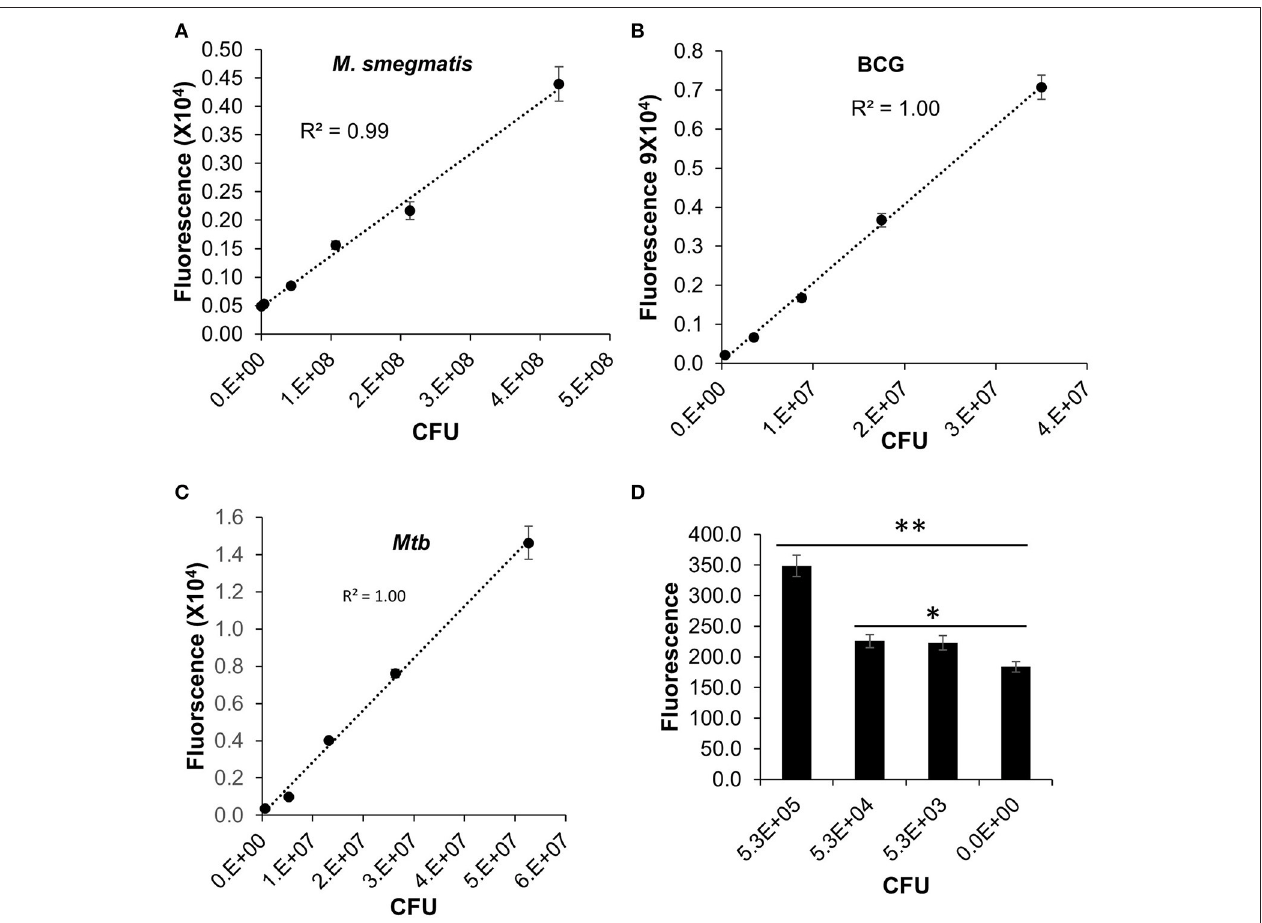
FIGURE 4 | Direct labeling of different mycobacteria with DLF-1. Fluorescent intensities of DLF-1 labeled bacteria were plotted against the numbers of bacteria. (A – C) represent plots for M. Smegmatis, M. bovis BCG , and Mtb CDC1551, respectively. Linear trend lines with R-squares are also displayed for each plot. Linear range: M . smegmatis 4.3 × 10 5 − 4.3 × 10 7 ; M. bovi s BCG 3.5 × 10 4 − 3.5 × 10 7 ; and Mtb 5.3 × 10 4 − 5.3 × 10 7 . (D) Minimum number of Mtb within the detectable linear range. ** P < 0.01; * P < 0.05. Error bars represent standard errors of means calculated based on results from three independent